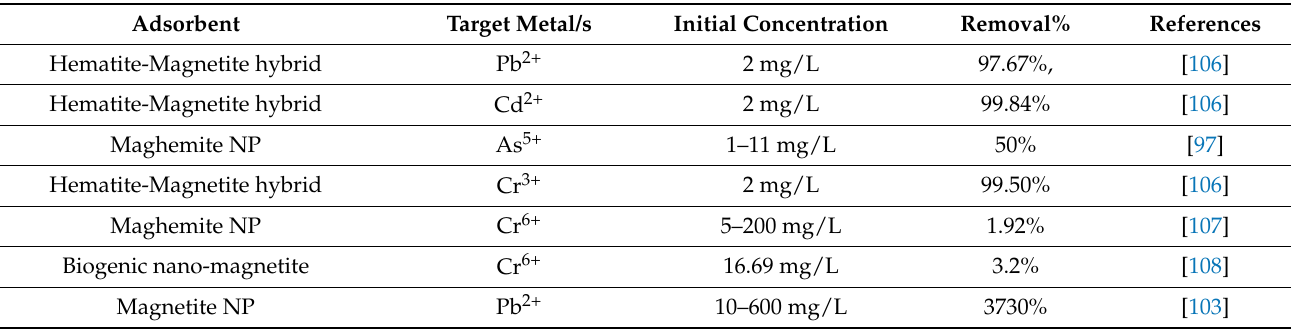
Table 5. Iron-oxide magnetic NP utilized for the removal of metallic ions from contaminated water.